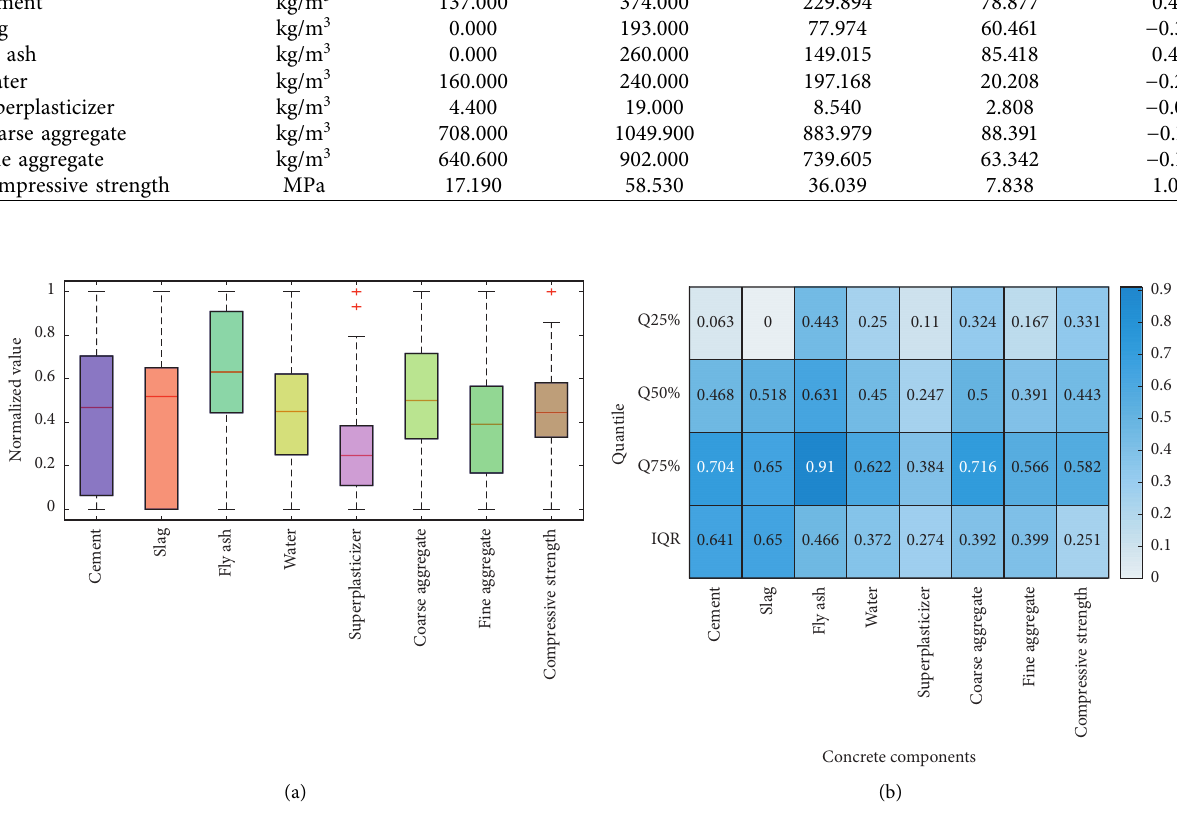
Figure 1: (a) Boxplot of normalized input and target variables and (b) Quantile percent of the concrete components.